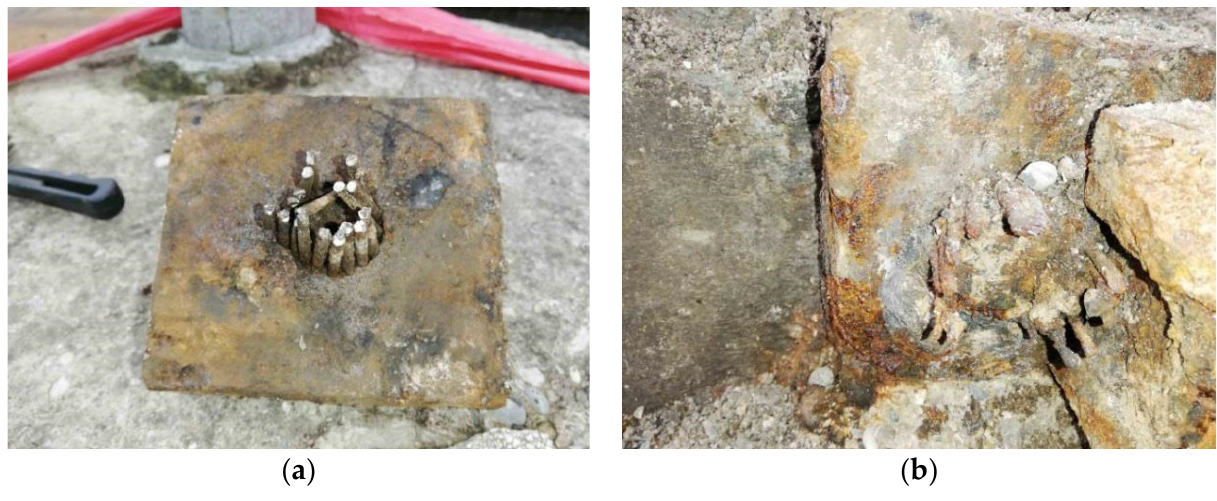
Figure 7. Anchorages—removed anchorage ( a ); detail ( b ).